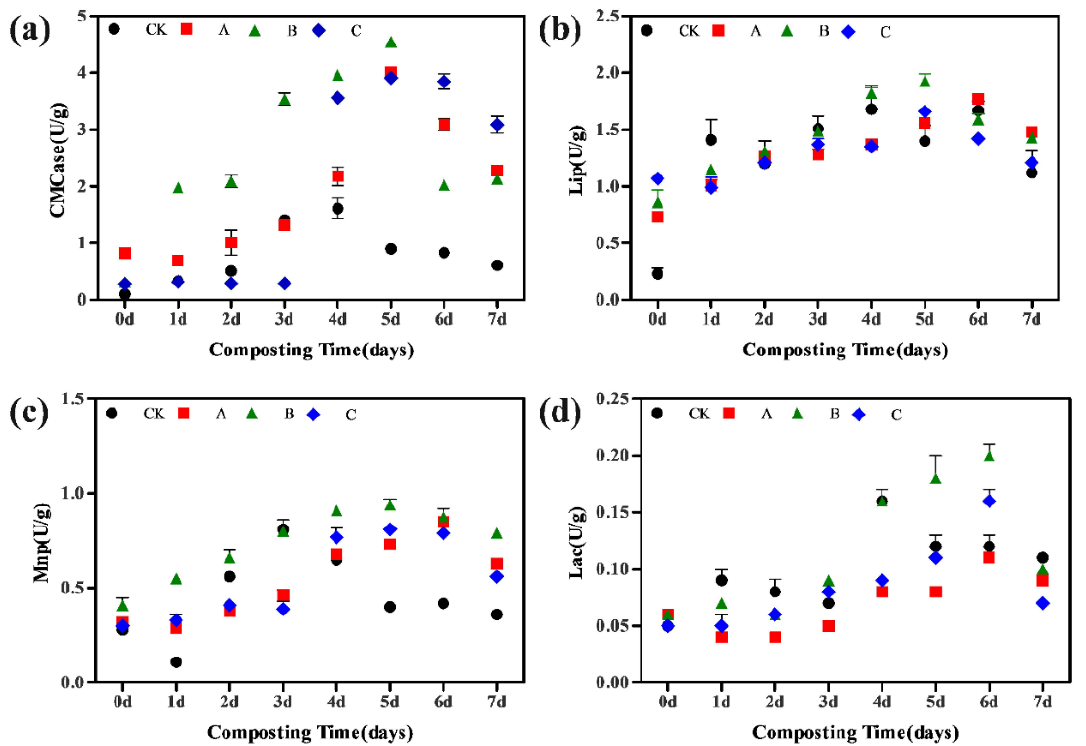
Figure 3. Changes in CMCase ( a ), Lip ( b ), Mnp ( c ), and Lac ( d ) in composts with different treatments. The bacterial alpha diversity indices at different composting stages are shown in Table 2. The coverage of all samples was no less than 99%, which proves their representa- tiveness. Simpson’s and Shannon’s indices indicated the bacterial community’s diversity. In contrast, the ACE, Chao, and Sobs indices revealed the microbial community’s overall con- tent and species richness, thus reflecting the microbial community’s overall state. Student’s T-test between the index groups of independent samples showed that the Sobs indices of